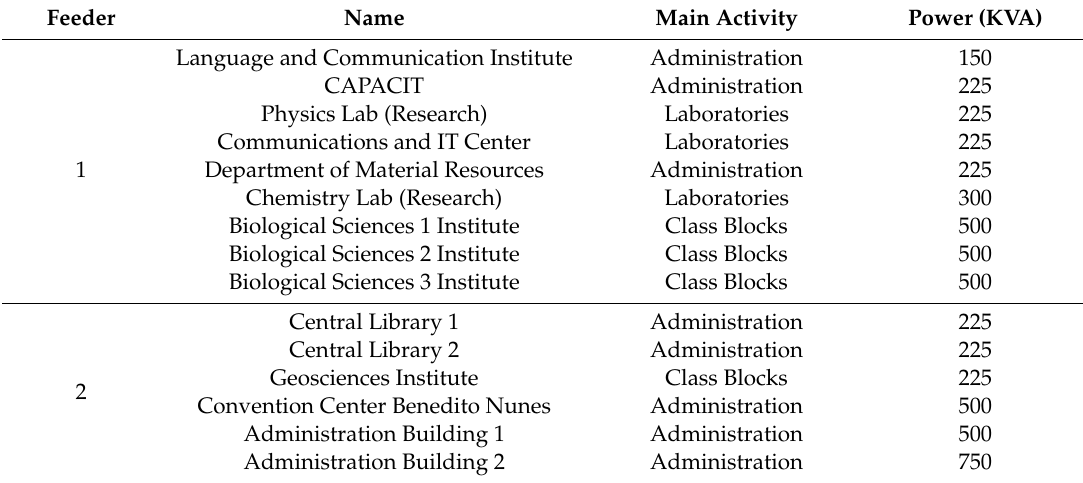
Table 5. SM by feeder and by